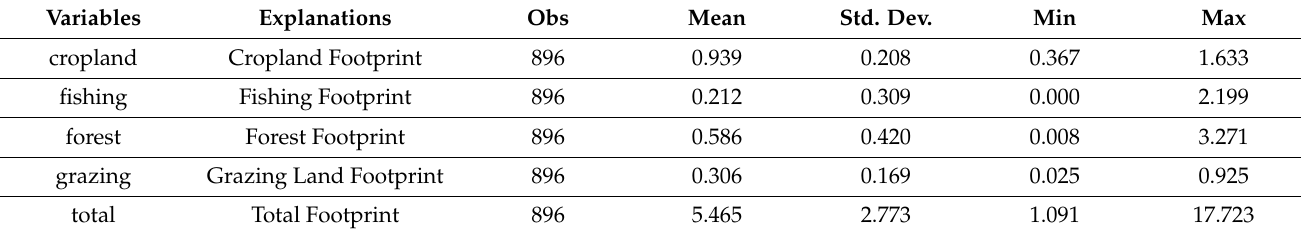
Table 1. Descriptive